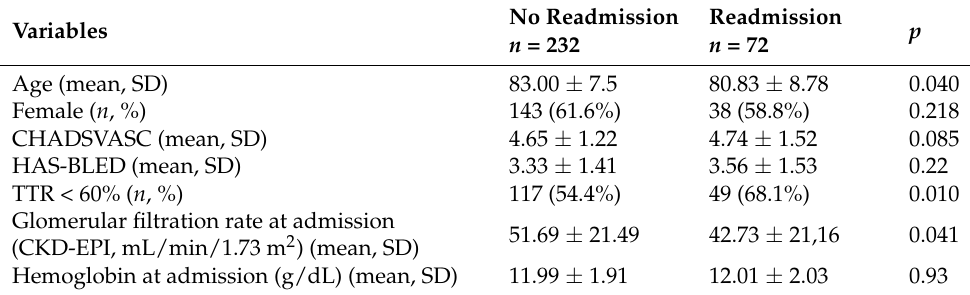
Table 3. Bivariate analysis between HF and non-valvular atrial fibrillation (NVAF) patients with and without hospital readmission within 30 days and adverse reaction to oral anticoagulation.